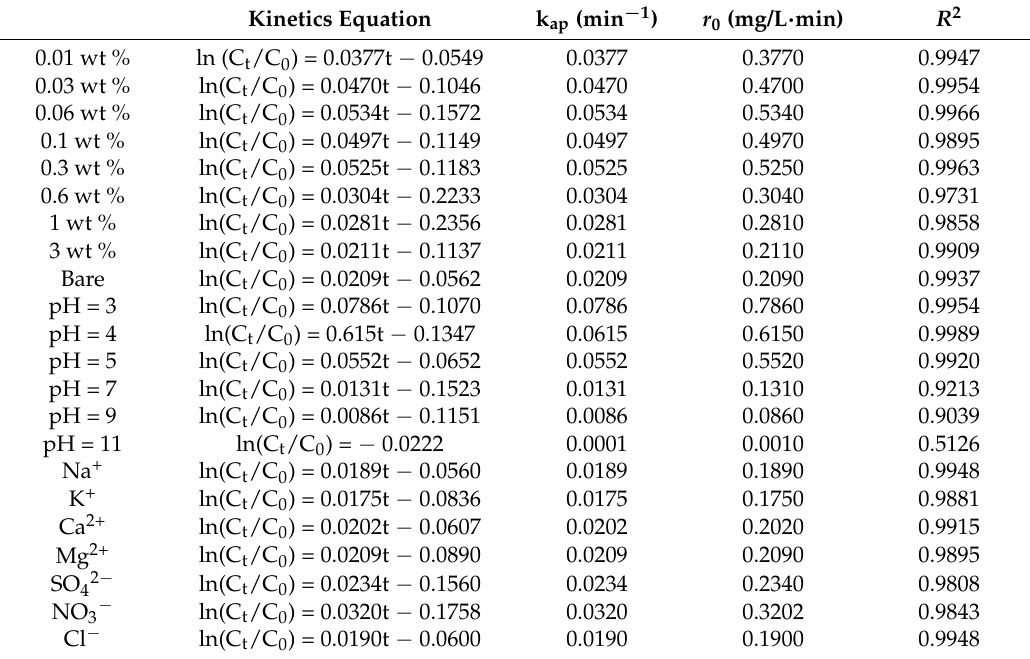
Table 2. The relevant parameters obtained from kinetic